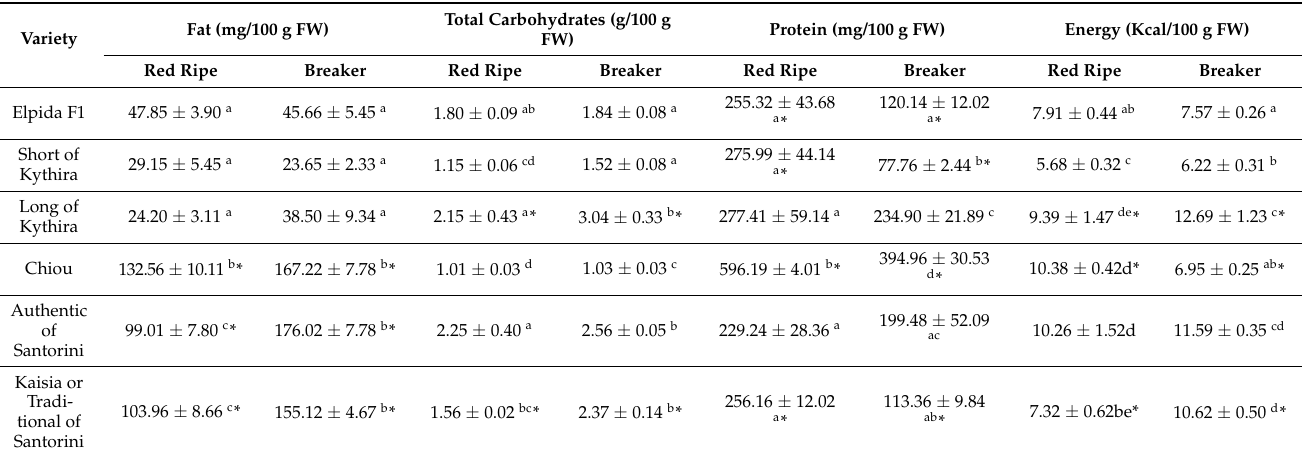
Table 2. Macronutrients and energetic value of six tomato varieties at red ripe and breaker ripening stage.